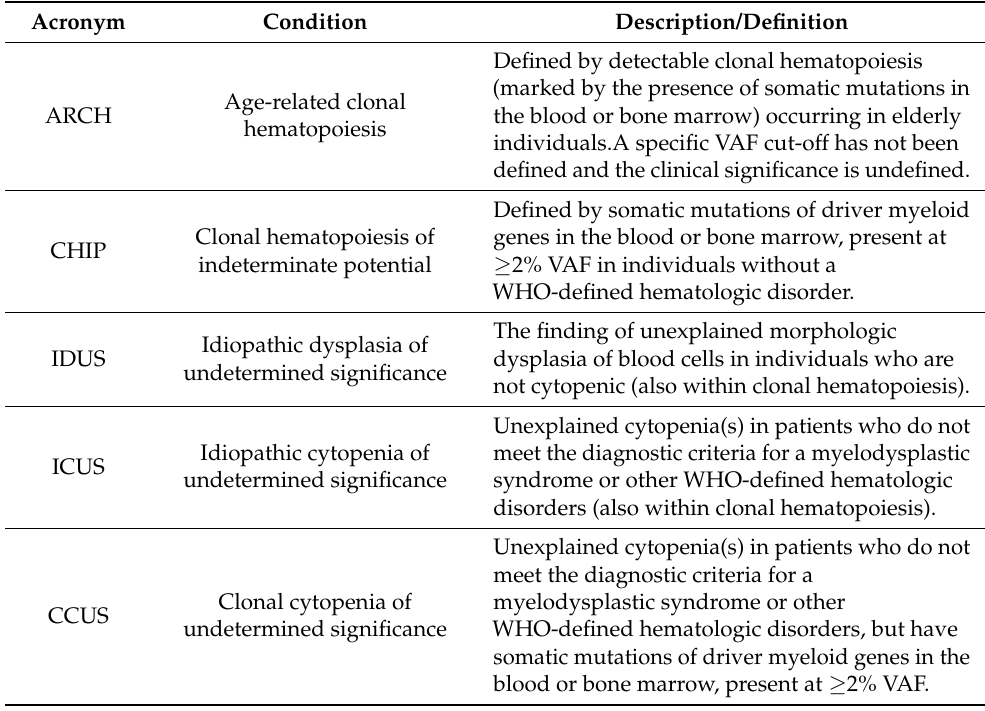
Table 1. Acronyms describing various scenarios of clonal